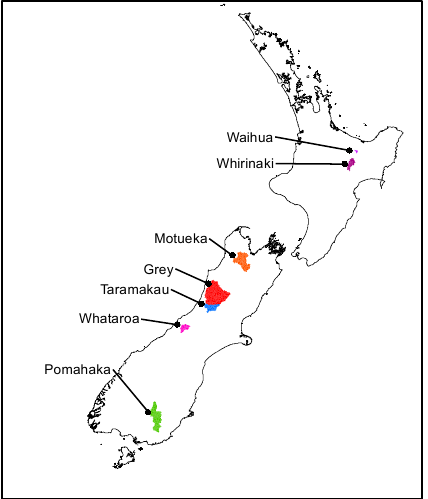
Fig. 4. Location of the seven test catchments within New